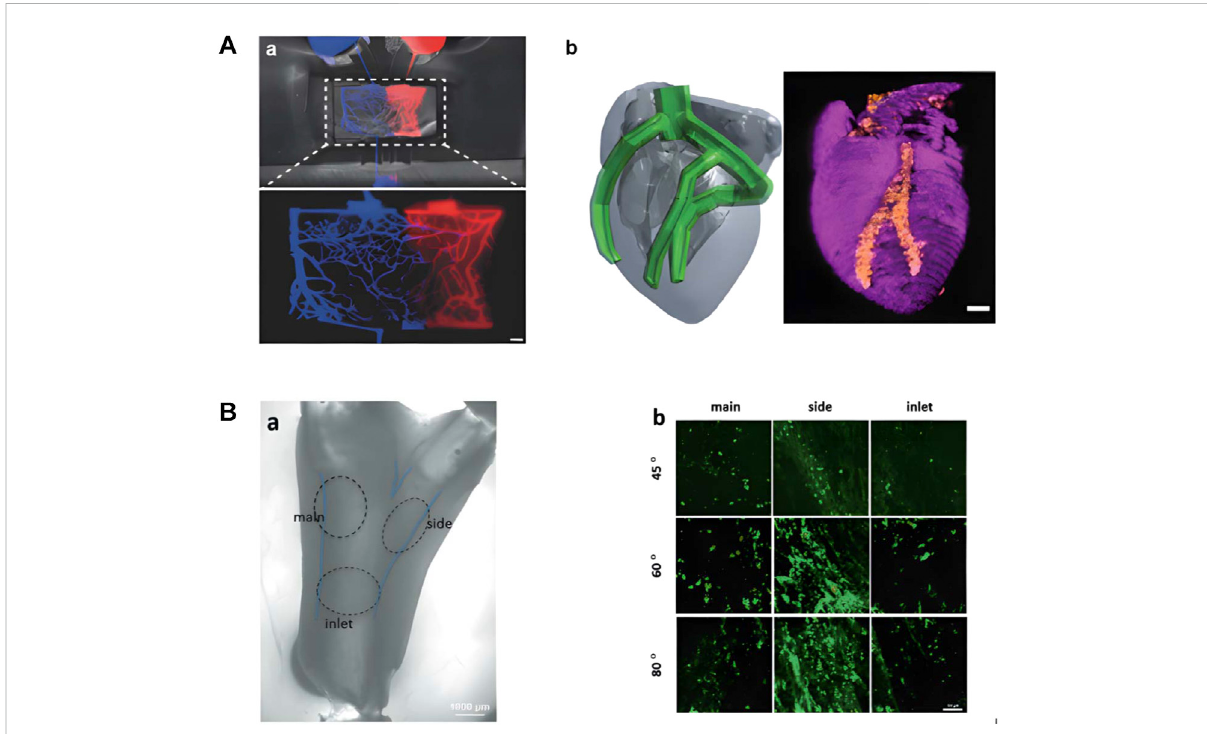
FIGURE 6 Research on arti fi cial tissue with potential application in medical imaging. (A) Related research on arti fi cial microvascular system. (a) Microvascular Networks Using Laser Patterns in Polyethylene Glycol Hydrogels. (b) 3D printed heart perfusion model (adapted and modi fi ed from Fleischer et al., 2020). (B) Bright fi eld and fl uorescence images of brTEBV. (a) Bright fi eld image of brTEBV with a branch angle of 45 ° considering MC adhesion, where the dashed circles mark the inlet, side, main regions. (b) Fluorescence images of green-labeled MCs in the brTEBV region (adapted and modi fi ed from Lee et al.,